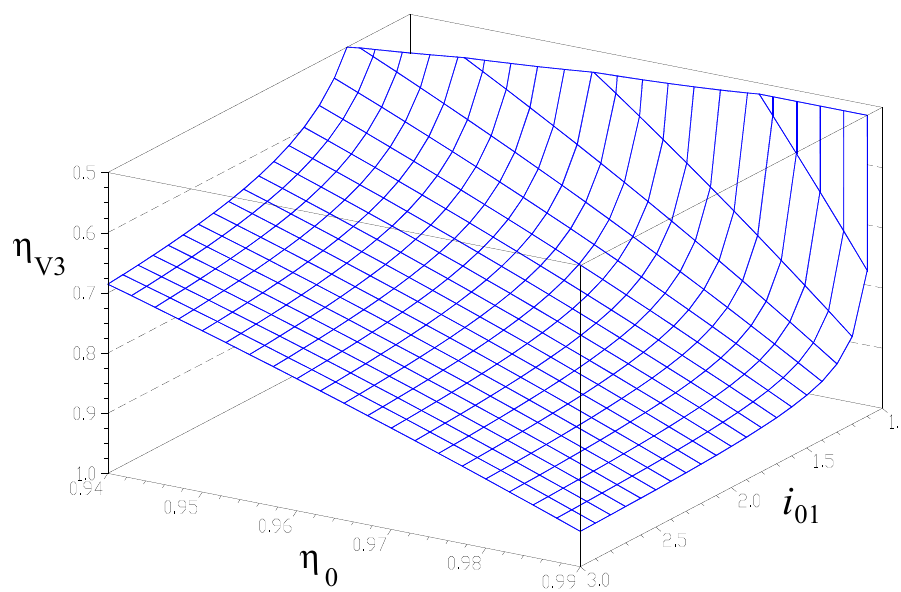
Figure 8. Efficiency of the 1-DOF speed increaser variant V3 (Figure 5c), as function of the interior kinematic ratio i 01 and η 0 .